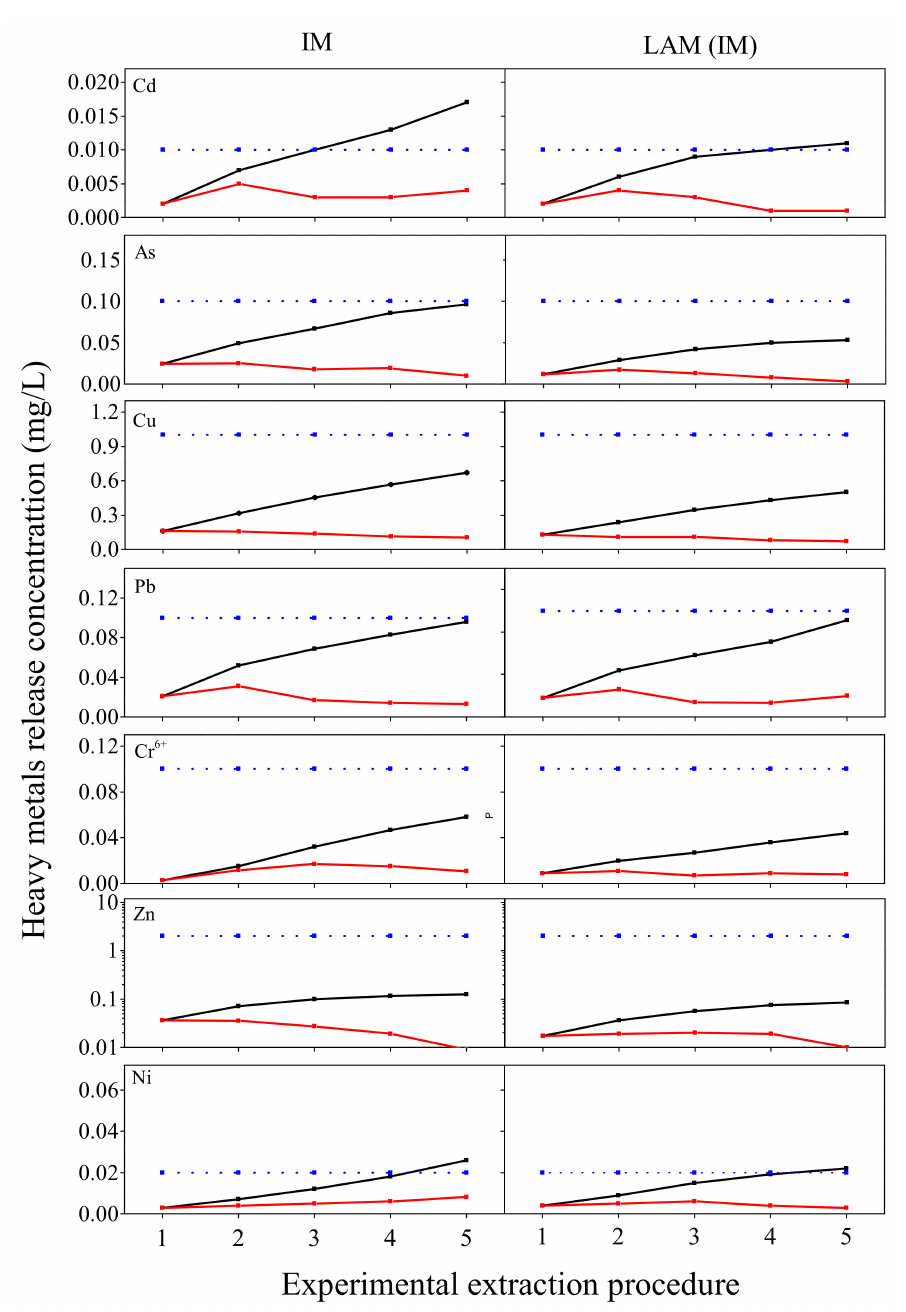
Figure 6. Release concentrations of the leaching events in progressive TCLP test; the red line represents concentration of di ff erent leaching cycles; the black line is cumulative leaching concentration and the blue line is Class IV limit of China Nations Environmental Quality Standards for surface